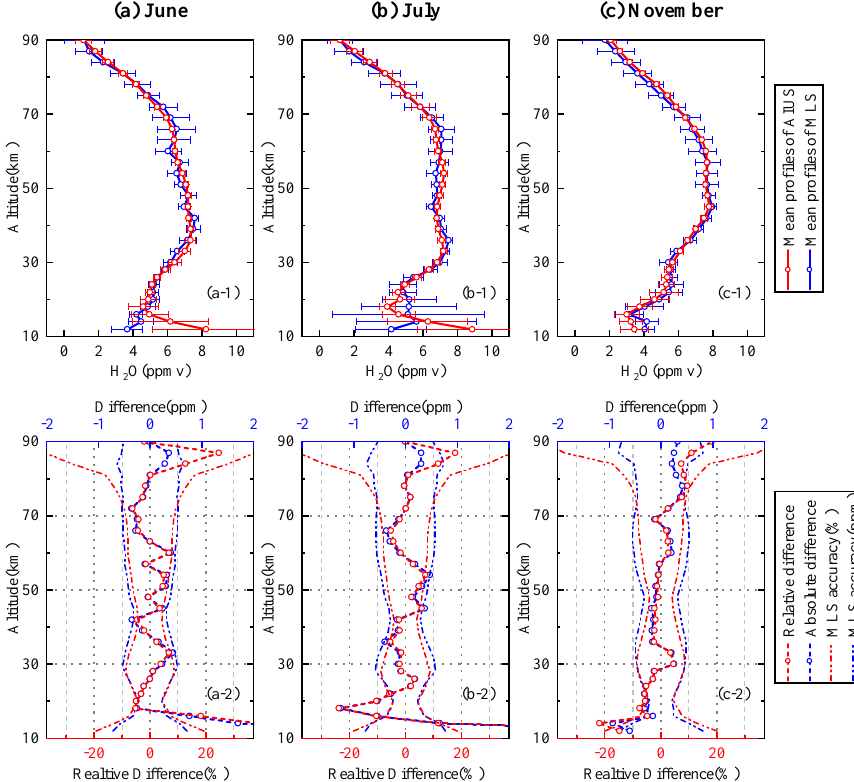
Figure 13. Same as Figure 12 except for 65 ◦ –70 ◦ S in June, July, and November.